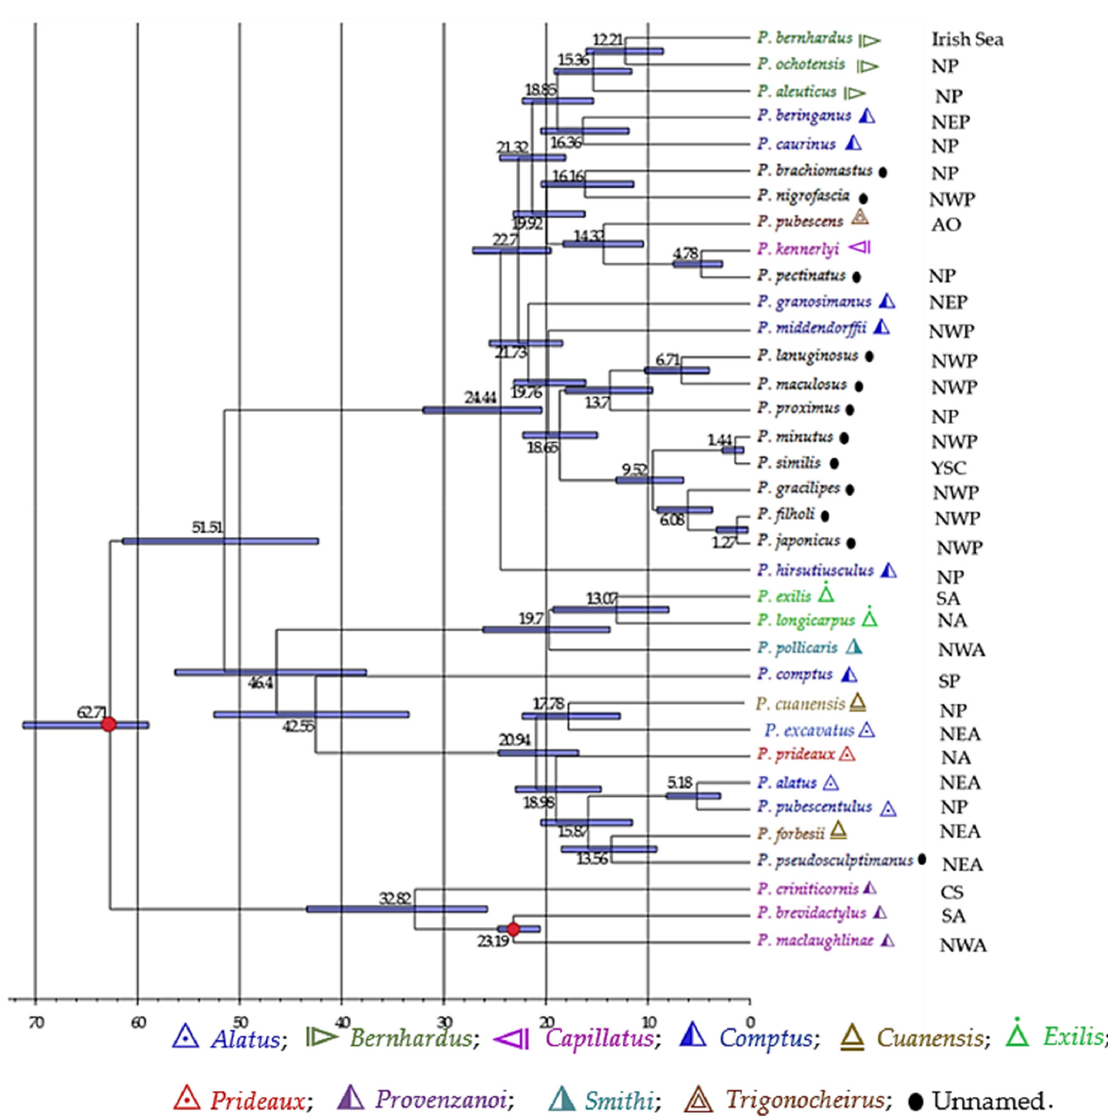
Figure 7. Dated phylogenetic tree of Pagurus species obtained from analysis of combined 16 and COI sequences. The evolutionary time-scale in millions of years ago (MYA) is shown below. The calibration points are shown in red circles. Different colors represent the morpho-based species groups.